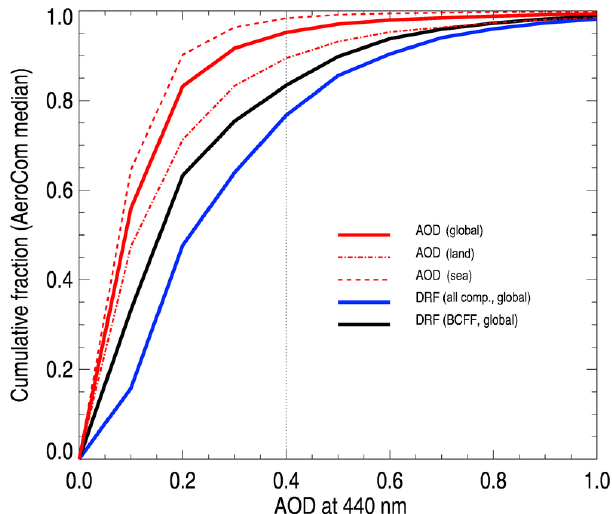
Figure 1. Cumulative AOD 440 frequency distribution (red lines) based on output from five AeroCom models. Blue and black lines show contribution of total aerosol and fossil fuel black carbon, re- spectively, to the global radiation budget as a function of AOD 440 . See text for details. Models used to generate the AOD lines in- clude GMI-MERRA-v3, GOCART-v4, LMDZ-INCA, OsloCTM2 and SPRINTARS-v385. Models used to generate the radiative forc- ing lines include all but the GMI-MERRA-v3 model. Model infor- mation and references can be found in Myhre et al.